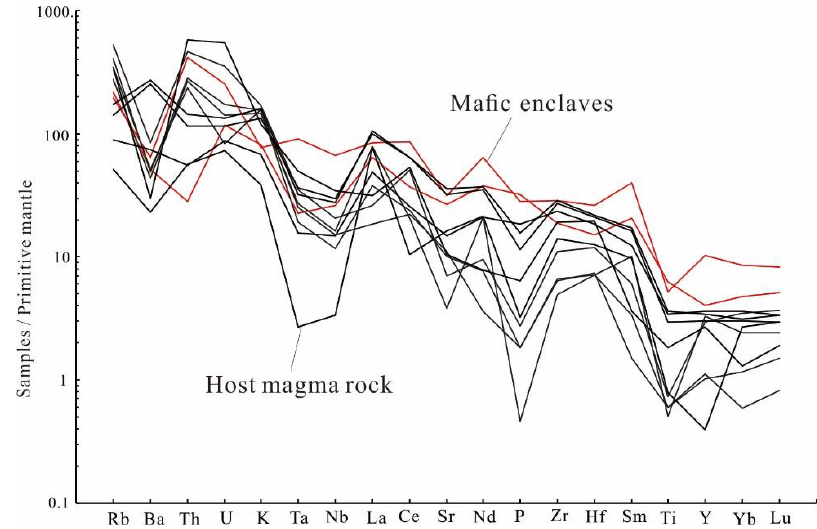
Figure 7. Primitive mantle-normalized trace element “spider” diagram of the mafic enclaves and the Qingshanbao host rock (Primitive mantle data are from Anderson [32]). Table 4. Trace element content of the mafic enclaves and the Qingshanbao host rock (wt/10 − 6 ). Samples